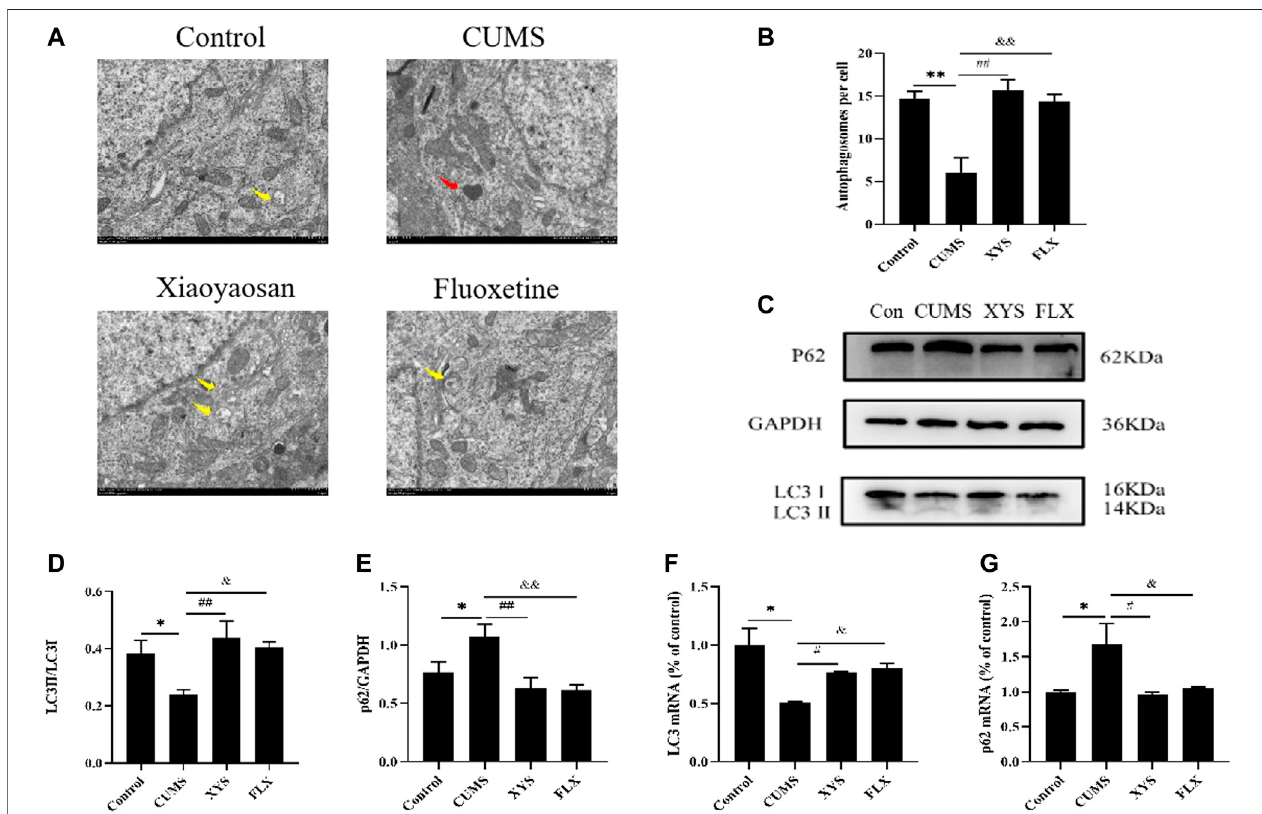
FIGURE 4 | Xiaoyaosan promote hypothalamic autophagy in CUMS-induced mice. (A) Transmission electron microscope showed the situation of autophagosomes and mitochondria in the hypothalamus of the mice (scale bar = 1 µm). Mitochondria were disrupted in CMS group (the red arrow). Autophagosomes were observed in control, Xiaoyaosan and fl uoxetine group (yellow arrows). (B) The number of autophagosomes in the hypothalamus of the mice (F (3, 8) = 13.383, p = 0.0017, n = 1). (C) Representative western blotting ofLC3 and p62 expressions. (D) Quantitative analysis ofprotein levels ofLC3(F (3, 16) = 4.904, p = 0.0133, n = 5). (E) Quantitative analysis of protein levels of p62(F (3, 16) = 5.931, p = 0.0064, n = 5). (F) The expression of LC3 mRNA (F (3, 12) = 7.326, p = 0.0047, n = 4). (G) The expressionofp62mRNA(F(3,12)=5.160, p =0.0161,n=4).Thevaluesrepresentthemean±SEM. p p < 0.05or pp p < 0.01comparedwiththecontrolgroup.# p < 0.05, ## p < 0.01 compared with the CUMS group. & p < 0.05, & p < 0.01 compared with the CUMS